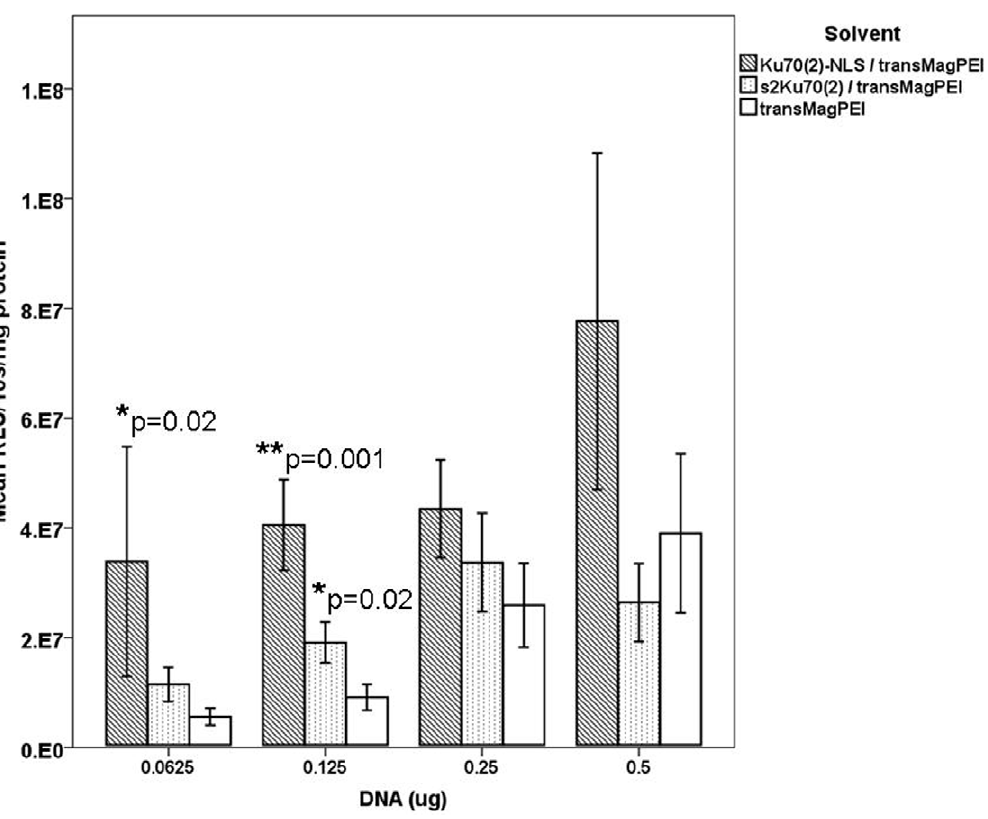
Figure 3. Transfection efficiency of ternary gene vector complexes using transMag PEI and different solvents. BEAS-2B cells were transfected with gene vector complexes. Transgene expression of Ku70 2 -NLS/transMag Pei /DNA is more efficient than s2Ku70 2 /transMag Pei and transMag Pei /DNA. *p=0.02 and **p=0.001.